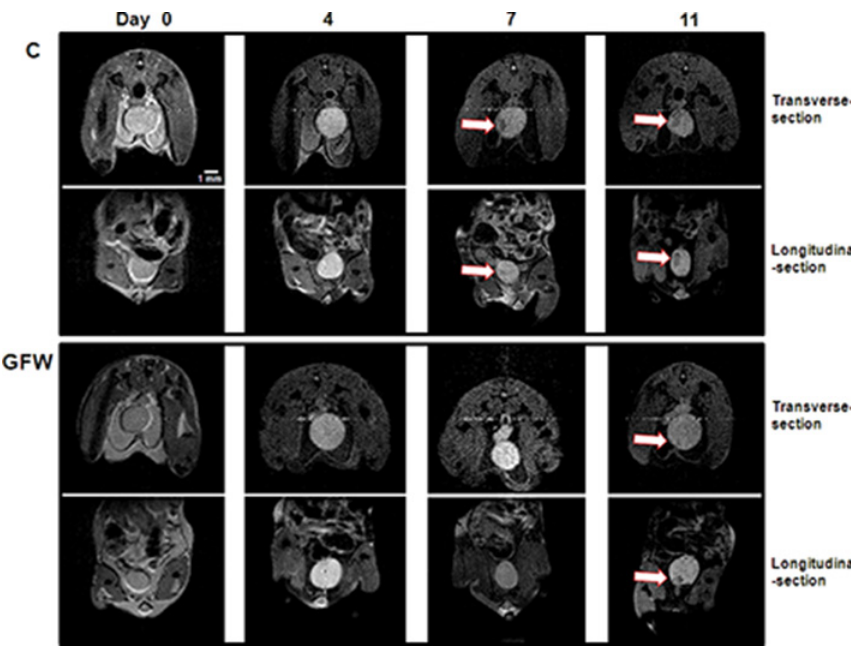
Figure 5. In vivo magnetic resonance detection of bladder tumor growth. Detection of bladder tumors was performed by using MRI on d 0, 4, 7 and 11 after implantation of mu- rine bladder cancer cells. A transverse section and longitudinal section of the MRI results were photographed. These images show tumors in the untreated control mice observed on d 7 and 11 (upper panel, C group), while a relative small tumor was observed in the GFW-treated mice on d 11 (the lower panel, GFW group). This demonstrates the retarda- tion of tumor growth by GFW. Arrows indicate bladder tumors. Scale bar, 1